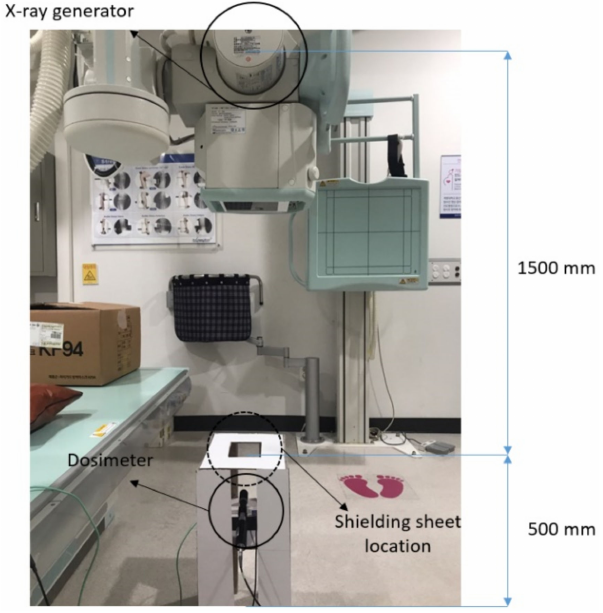
Figure 3. Evaluation of radiation-shielding performance of shielding sheets.